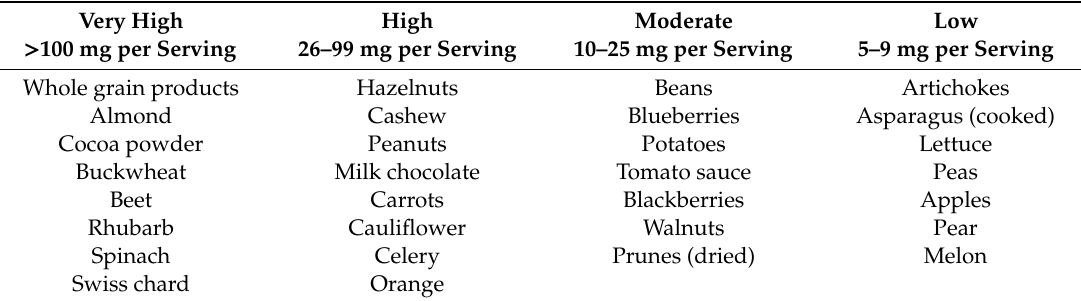
Table 4. Foods grouped in 4 categories by oxalate